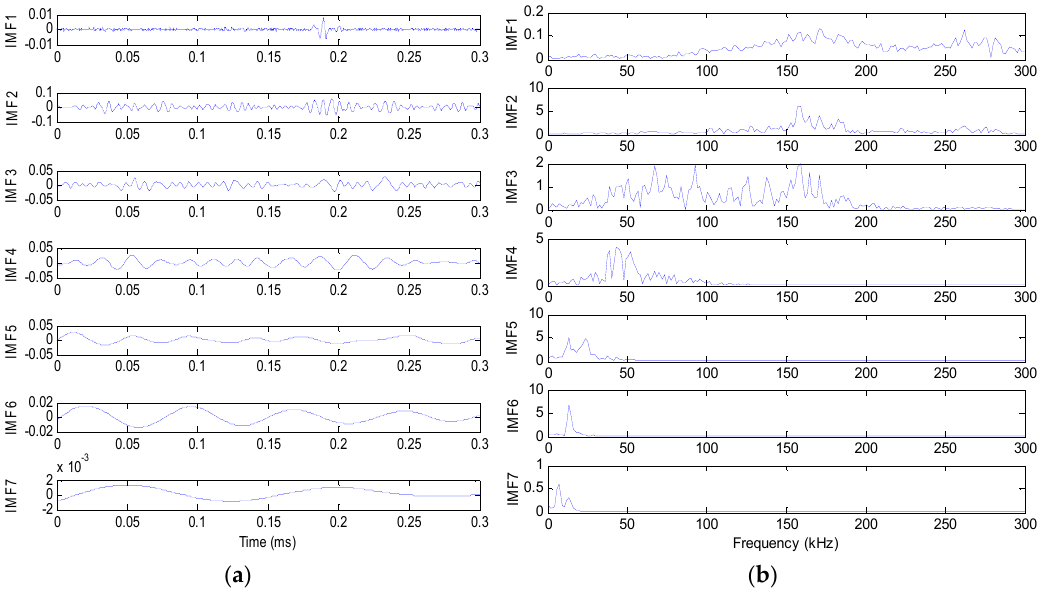
Figure 7. EEMD results of the leak signal. ( a ) Decomposed time domain signal waveforms; and ( b ) decomposed frequency spectra.